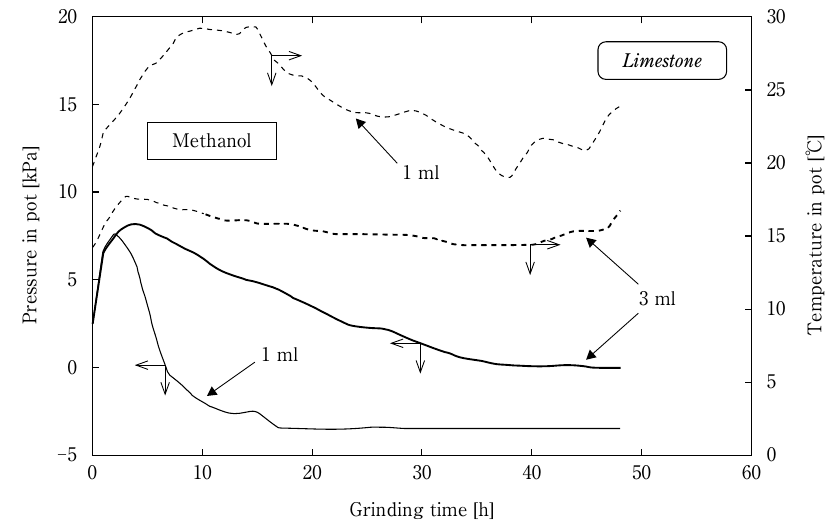
Fig. 10 Variations of the temperature and pressure in grinding pot as a function of grinding time with the addition of